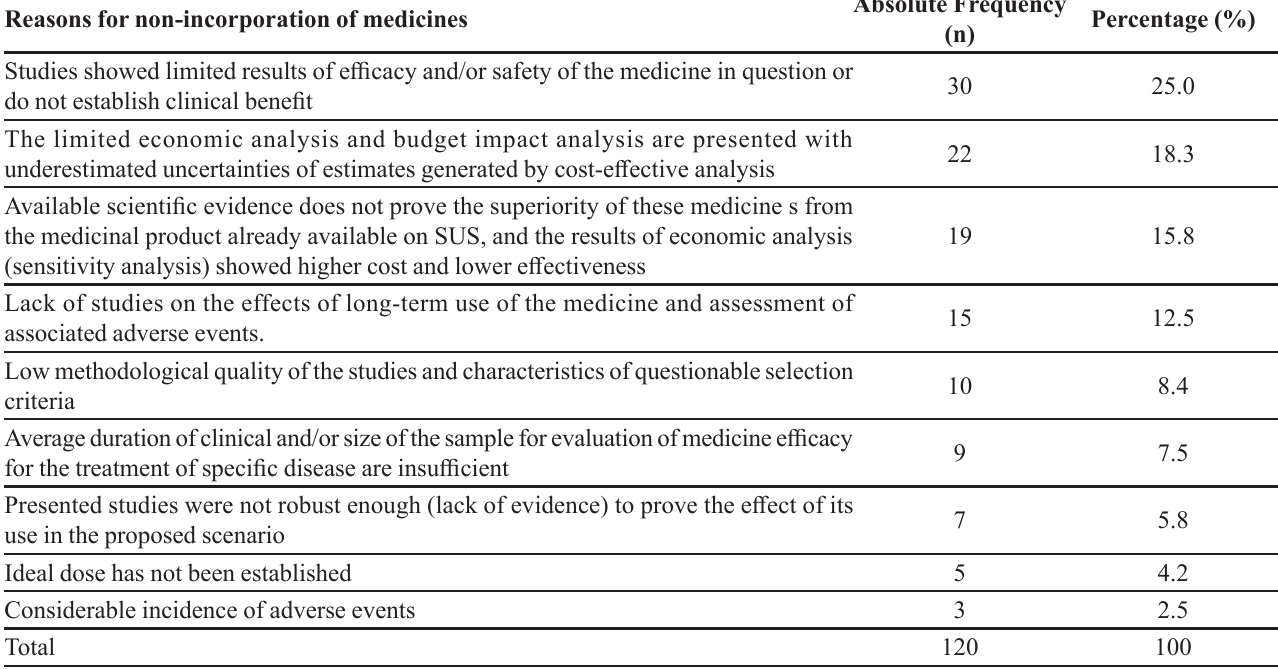
TABLE IV - Distribution of reasons for non-incorporation of medicines requested. January 2012 - July 2015,